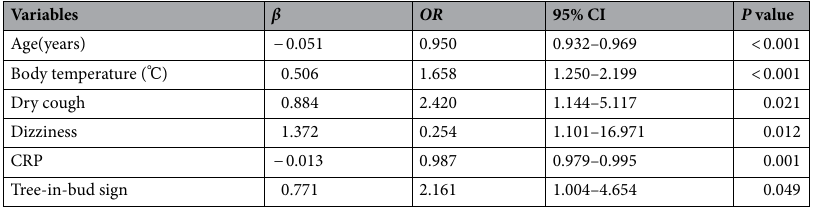
Table 2. Multivariable logistic regression analysis of MPP in adults.